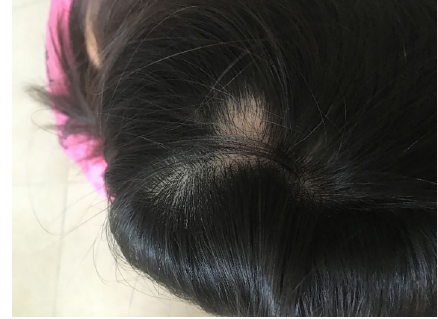
Figure 1 . Zone of hair loss.